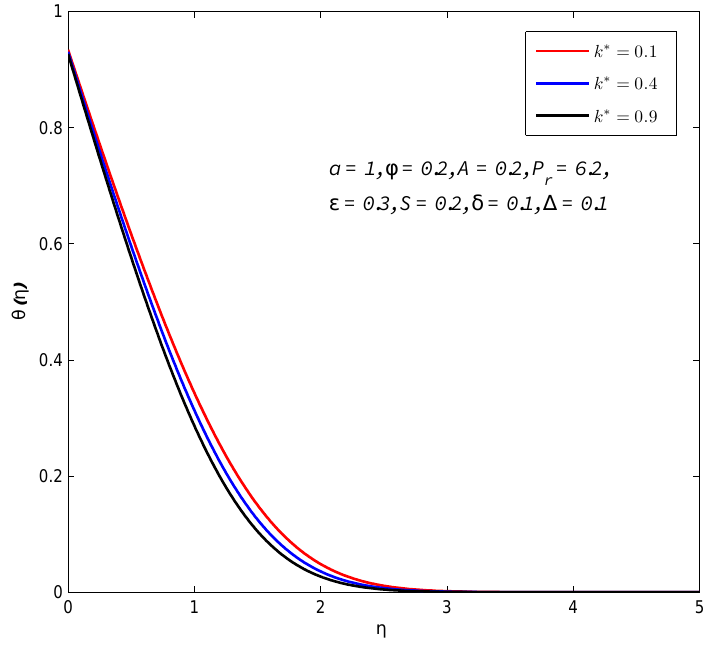
Figure 4. Temperature θ ( η ) profiles for different values of permeability parameter k ∗